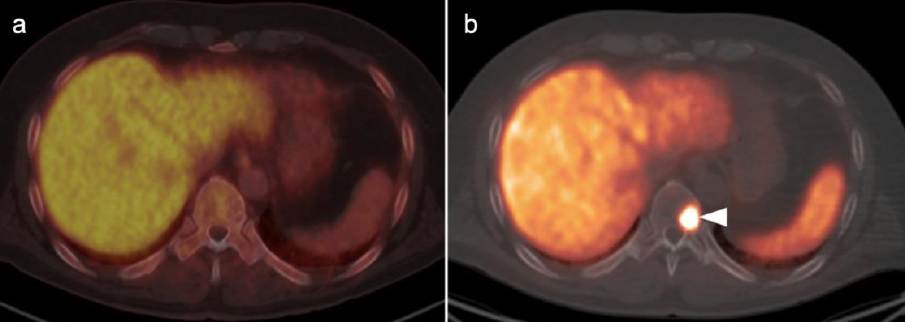
Figure 26. Comparison of [ 18 F]-fluciclovine negative but [ 18 F]- PSMA-positive PET-CT scans in a prostate cancer patient with a bone metastasis. ( a ) [ 18 F]-fluciclovine PET-CT scan is negative; ( b ) [ 18 F]- PSMA scan is positive in a metastatic lesion of a lower thoracic vertebral body (white arrowhead) vertebral metastasis.